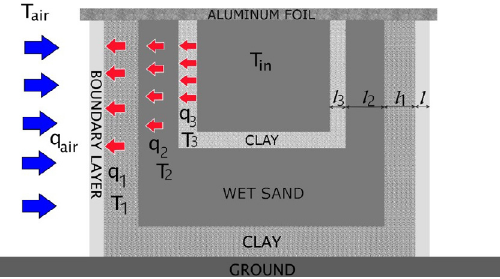
Fig. 2. Geometry of pot-in-pot cooler and the distribution of the heat fl uxes at dynamic equilibrium.